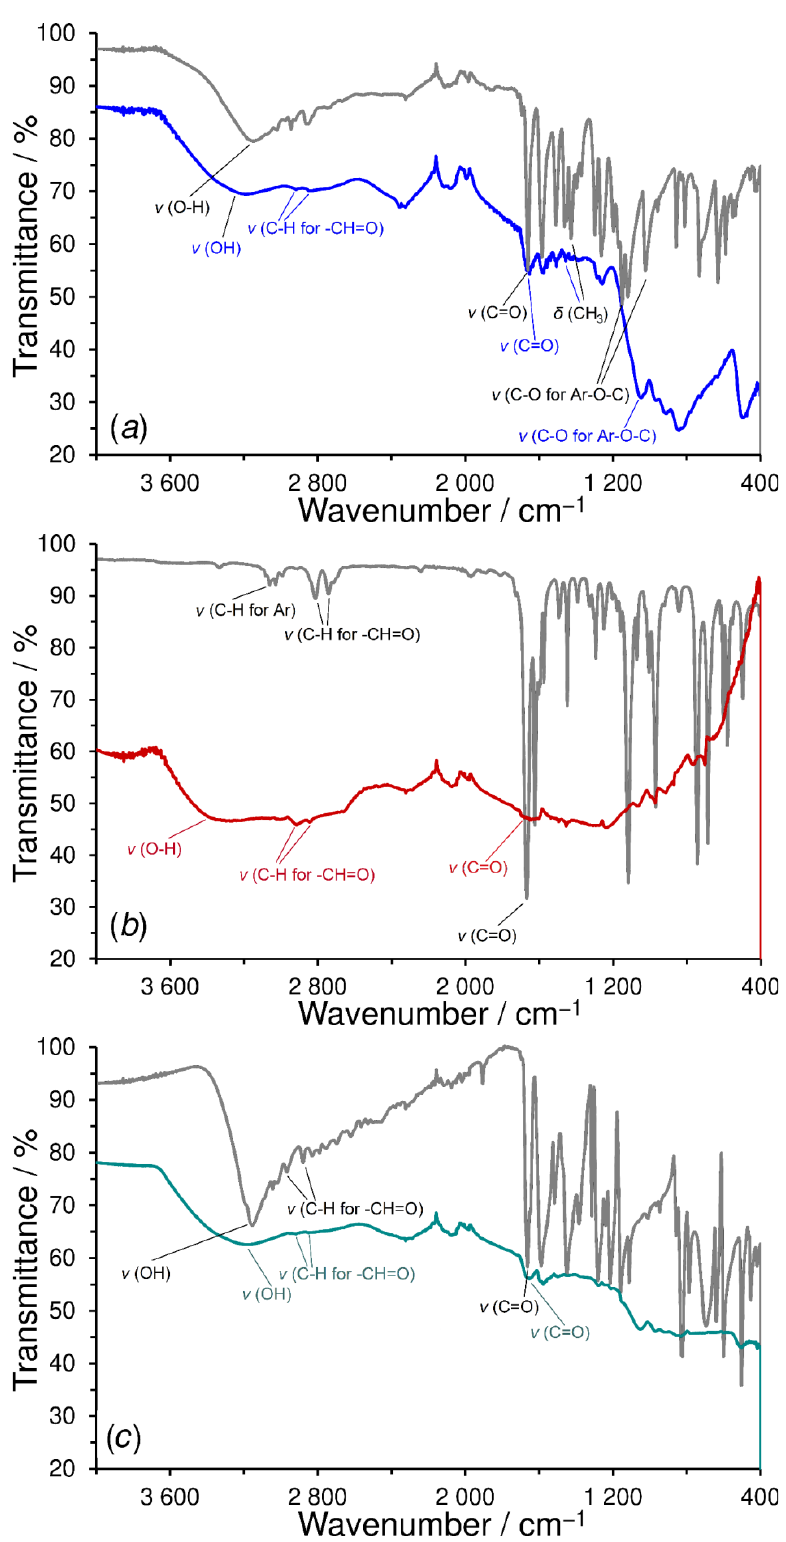
Figure 3. FTIR spectra of vanillin with poly-vanillin ( a ), trans -cinnamaldehyde with poly- trans - cinnamaldehyde ( b ), and 4-hydroxybenzaldehyde with poly-4-hydroxybenzaldehyde ( c ). Spectra of monomers are colored in